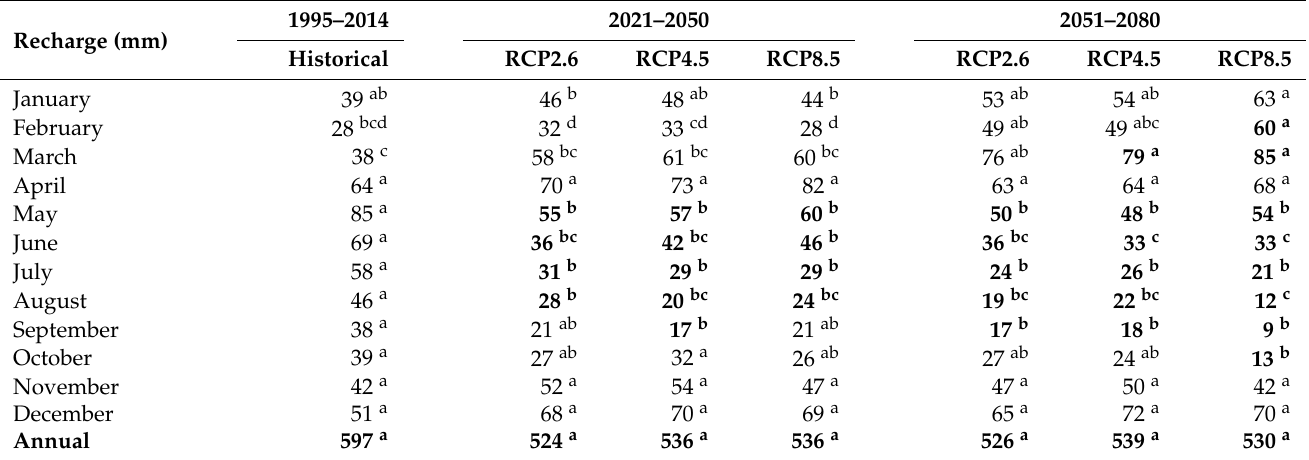
Table 7. Average recharge (mm) in the eastern zone (Bear River watershed) during 1995–2014 and modeled future projections during the 2030s and